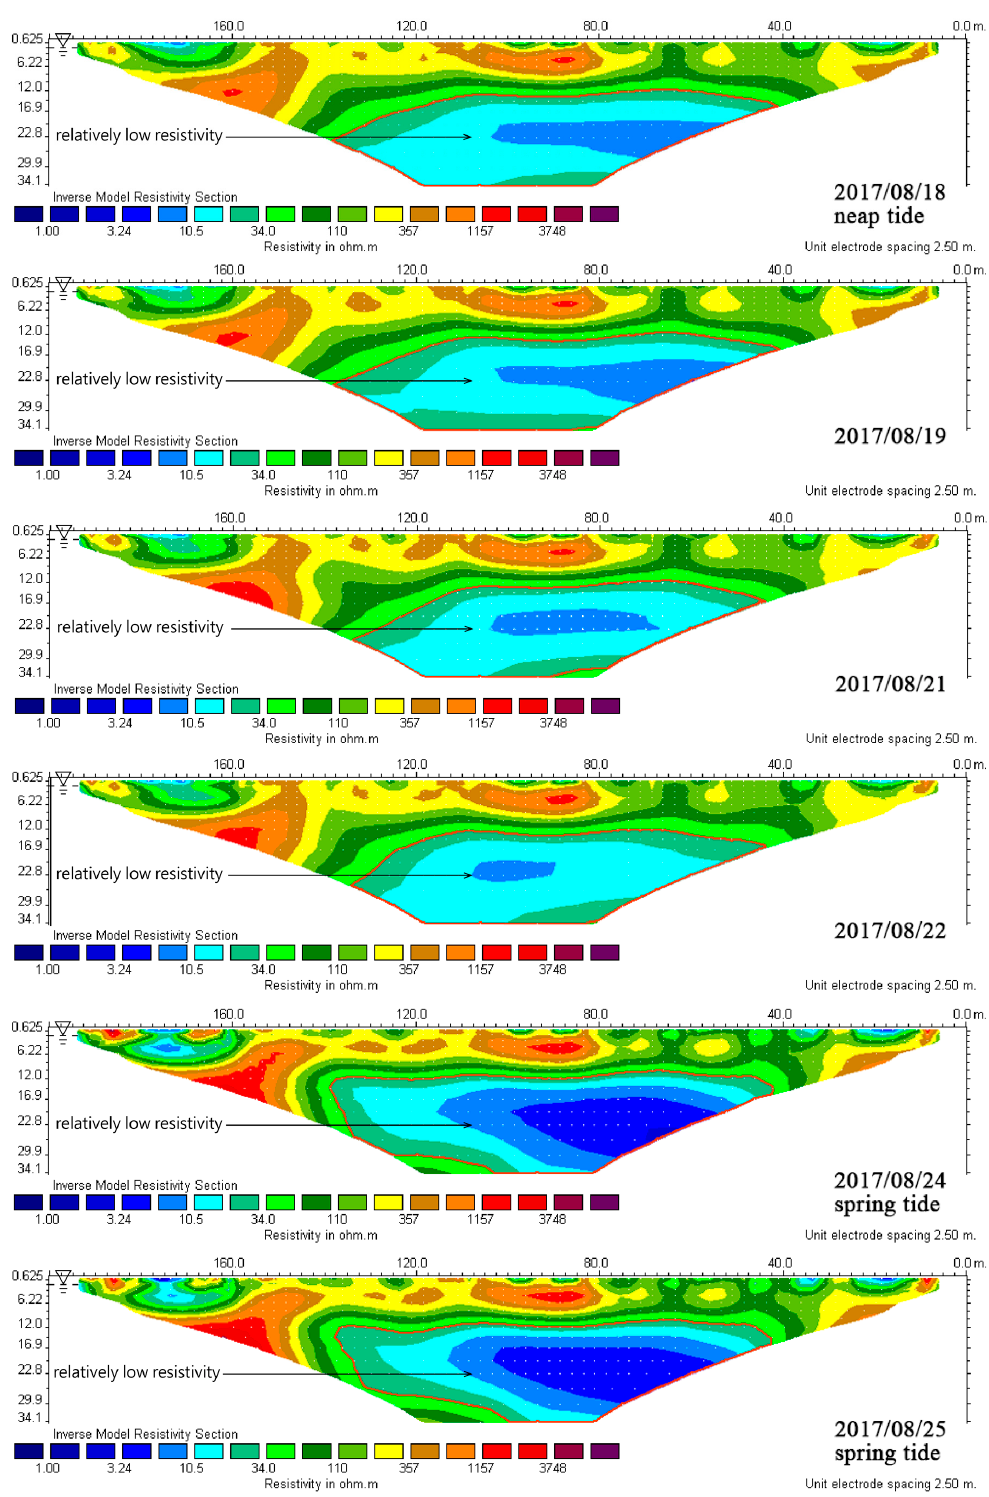
Figure 8. Ground Resistivity Profile of Measuring Line L2 from 9 August 2017 to 25 August 2017.